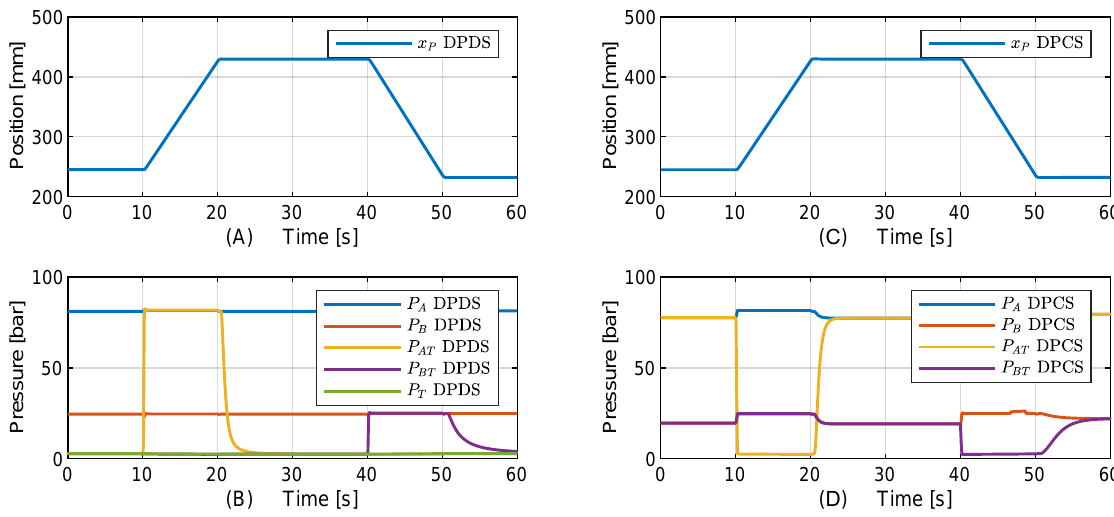
Figure 9. Results with velocity step sequence with F ext = 20 [kN] and P set = 25 [bar]. ( A ) Piston position for DPDS drive. ( B ) Relevant pressures for DPDS drive. ( C ) Piston position for DPCS drive. ( D ) Relevant pressures for DPCS